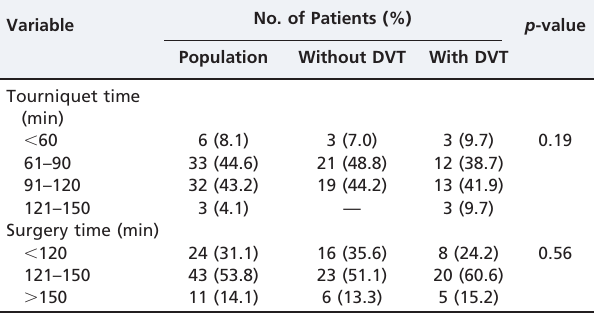
Table 3 - The population distribution by tourniquet (n= 74) and operative times (n= 78) and a comparative analysis of patients with and without proximal